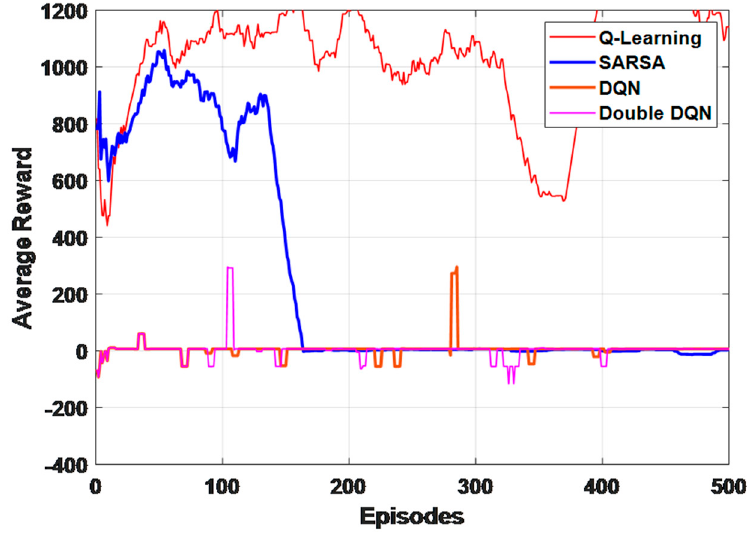
Figure 10. Figure 10. Comparative Analysis of Convergence Speed with Respect to Episodes for Different Algorithms.